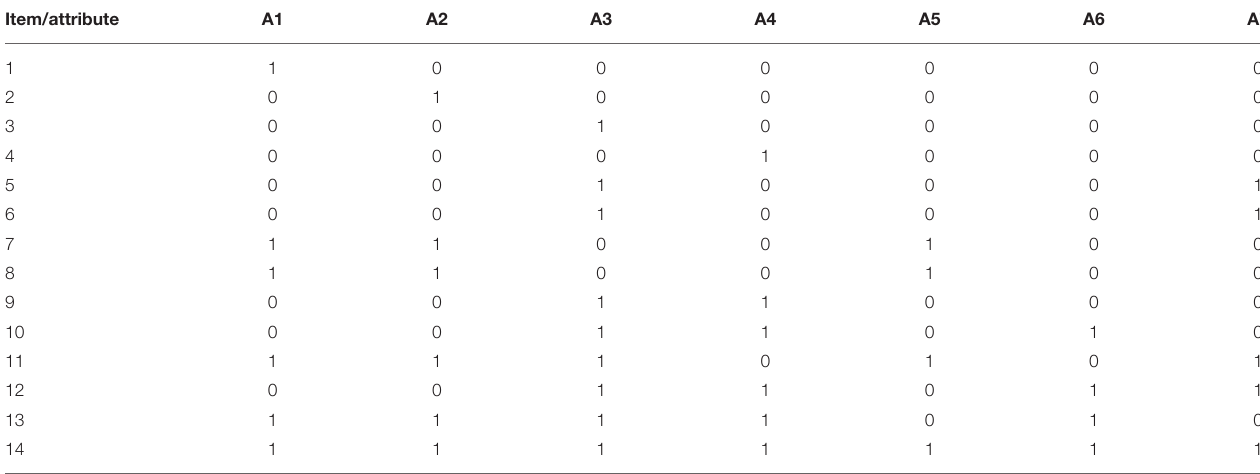
TABLE 9 | The Q-matrix for buoyancy concept learning. Item/attribute